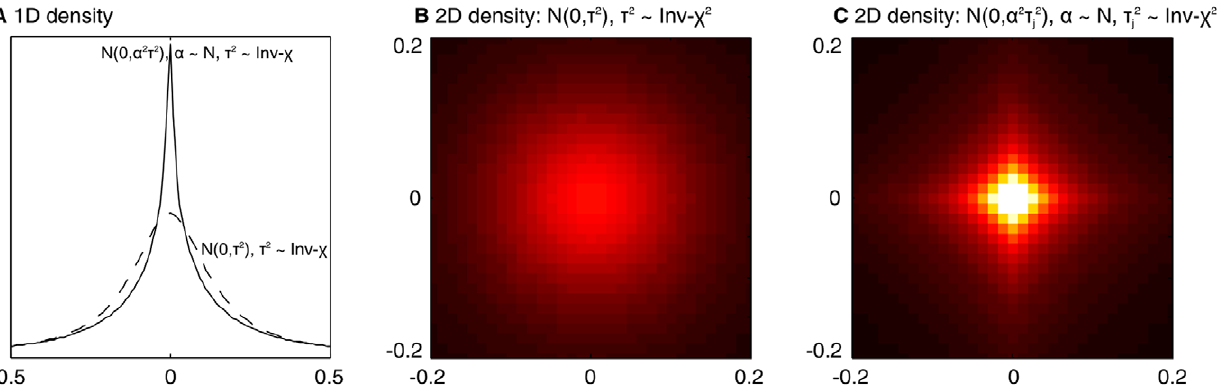
Figure 1. Illustration of the effect size prior. A. b prior density with Inv { x 2 and noncentral-F (from a 2 t 2 with a * N and t 2 * Inv { x 2 ) distributions for the variance. The former yields a t -distribution. The latter is more spiked. Both have heavier tails than normal distribution. Panels B and C show the comparison in two dimensions (pseudo-colored histograms with dark as low and bright as high values). In the former the two b s share the t 2 parameter, whereas they have independent t 2 parameters in the latter. The plots were constructed from 50 million samples with fixed ~ 0 : 02 (and assuming s 2 ~ 1 ). prior parameters m ~ 1 , n t ~ 1 and s 2 t